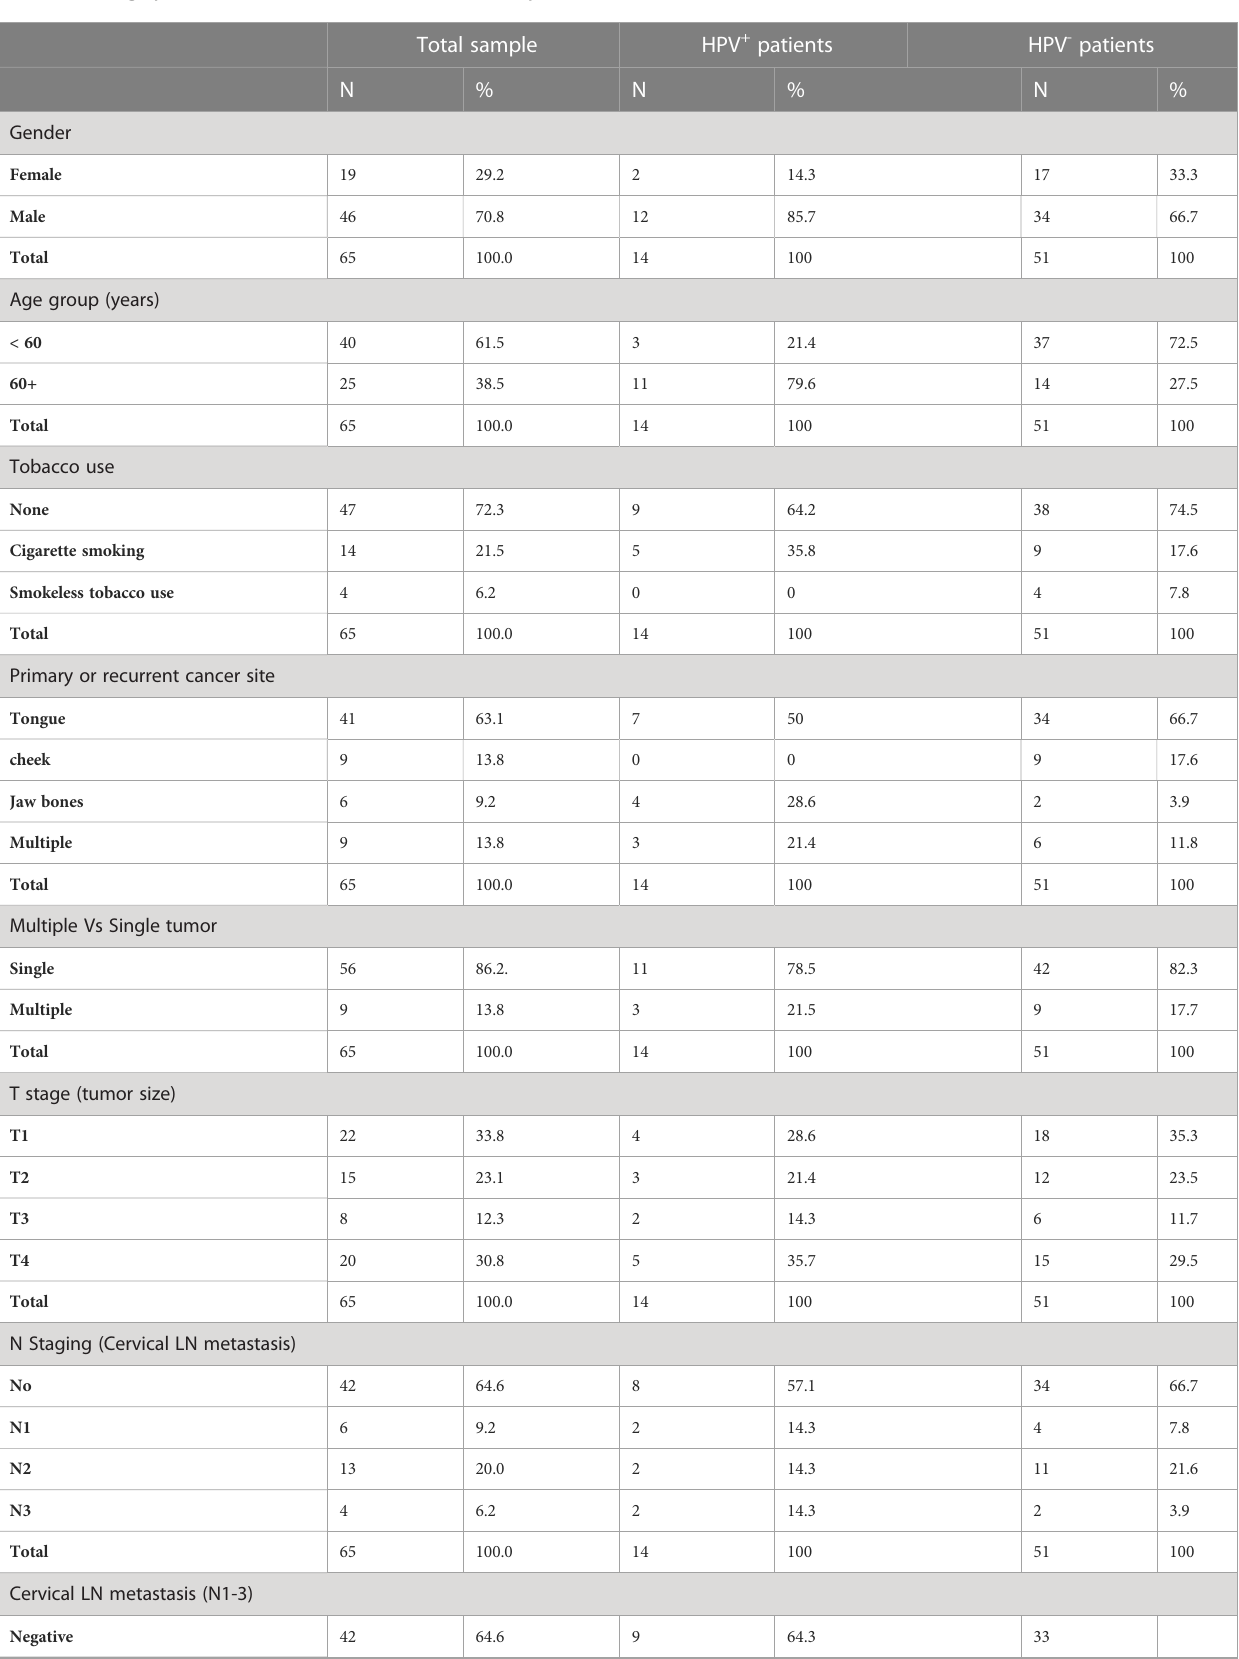
TABLE 2 Demographic and Clinical characteristics of the OSCC patients. Total sample HPV +